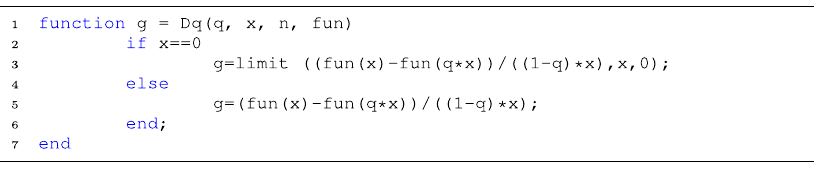
Algorithm 3 The proposed method for calculating ( D q f )( x